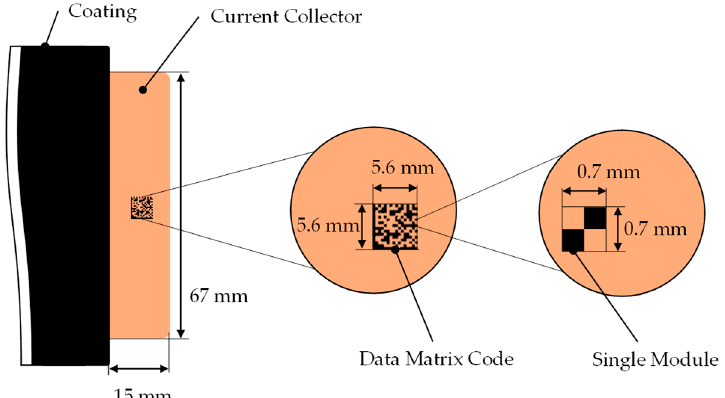
Figure 6. Schematic anode illustration of an iwb pouch cell format current collector. The available size was 67 mm × 15 mm. A DMC was applied with a size of 5.6 mm × 5.6 mm. The figure shows a full-scale image of a possible code and the current collector.